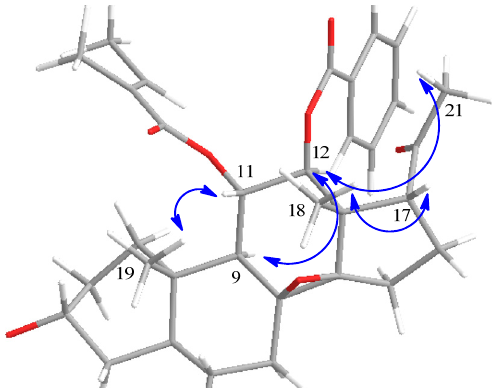
Figure 3. Key ROESY correlations of the aglycone of 1 .